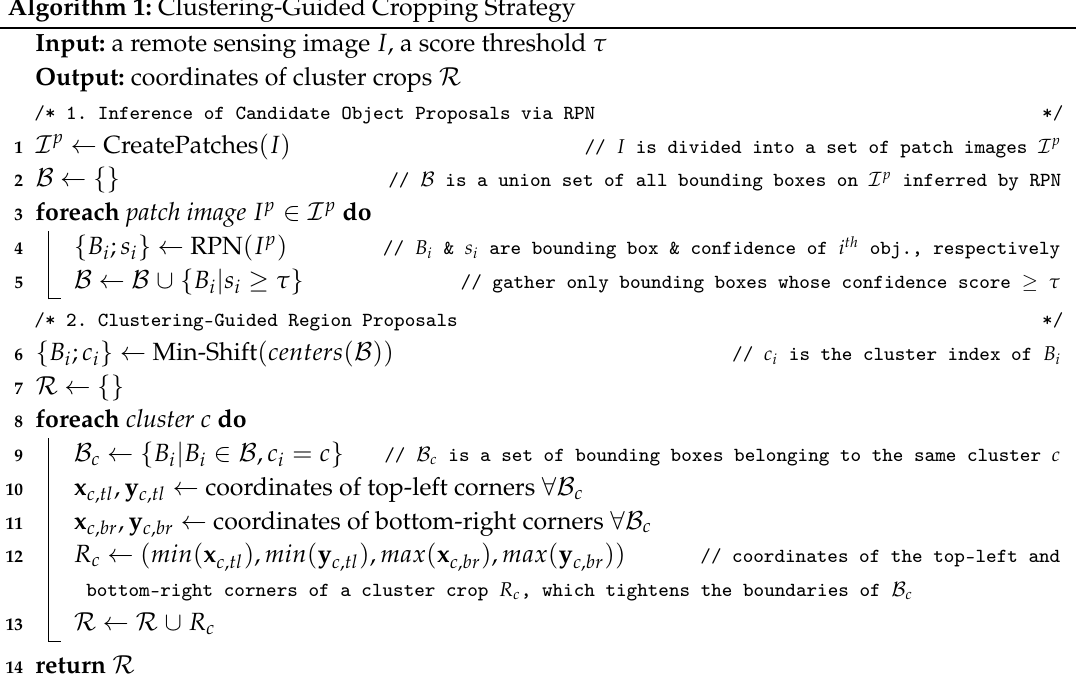
Algorithm 1: Clustering-Guided Cropping